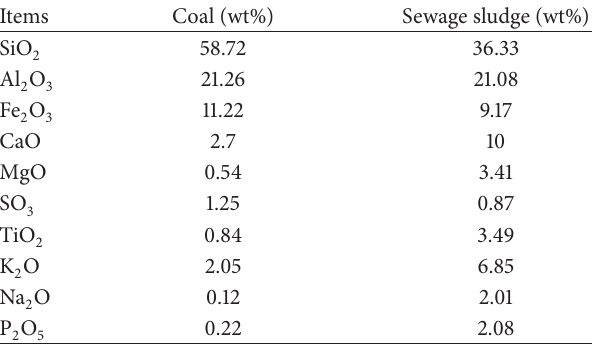
Figure 2: Influence of furnace temperature on N 2 O